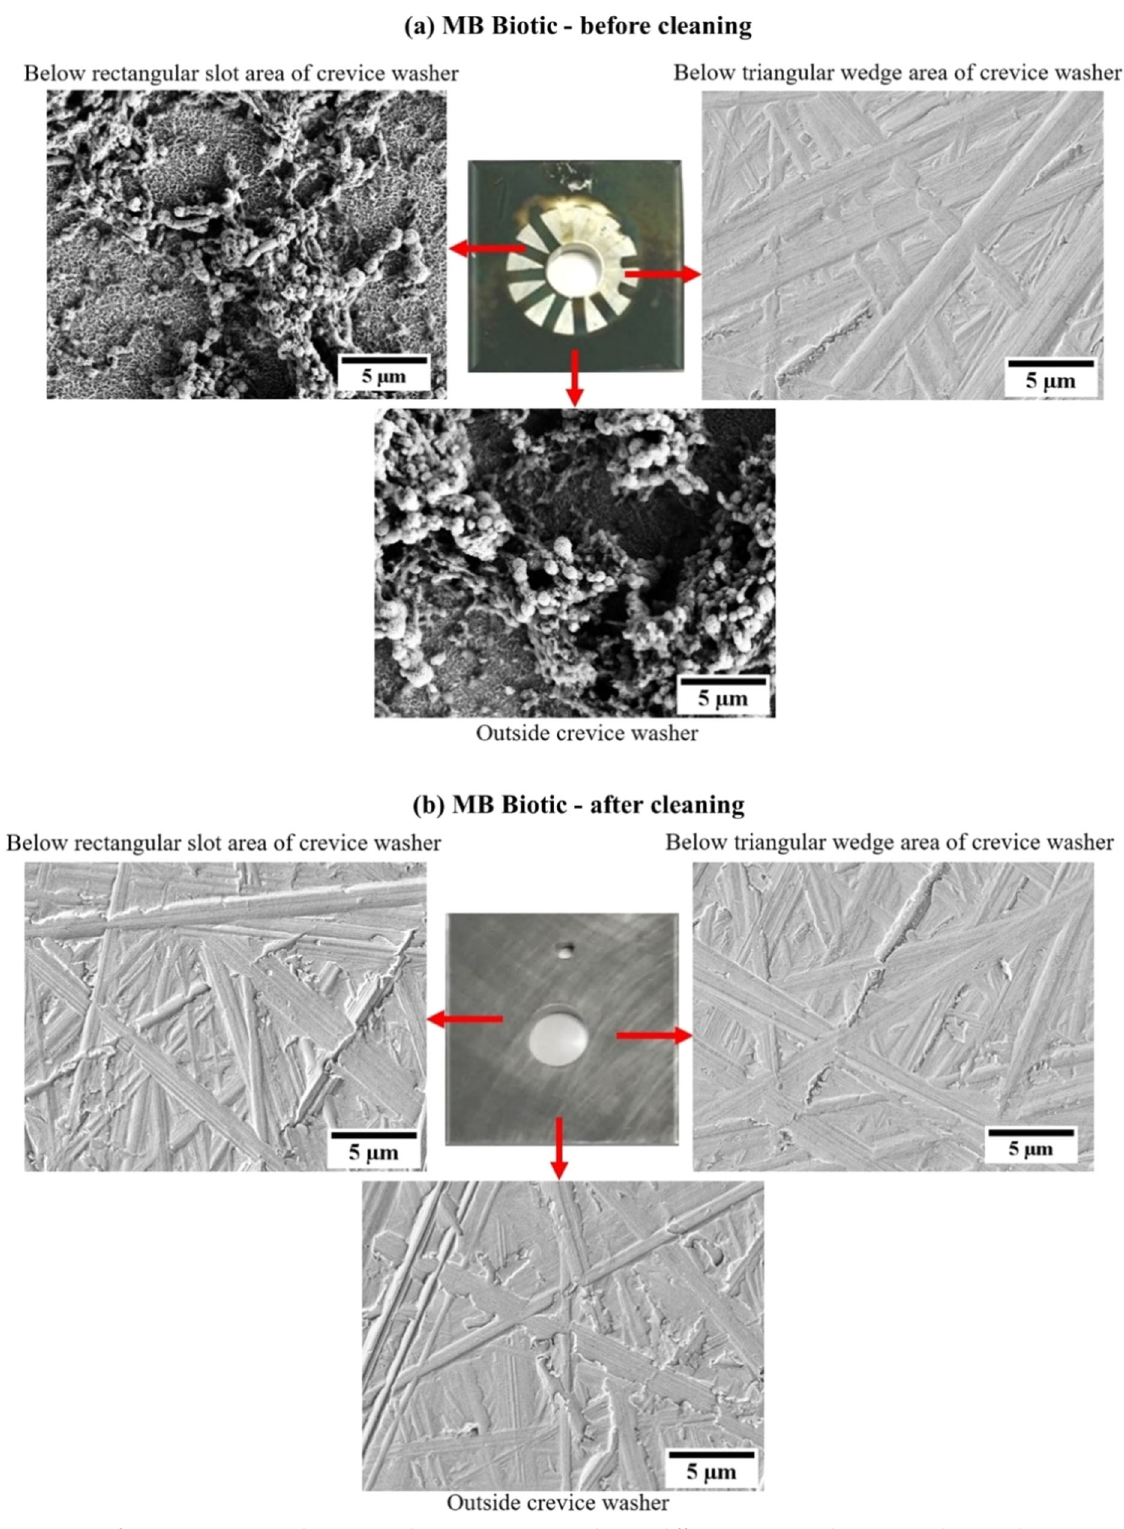
Fig. 3 SEM images of coupons immersed in MB medium. SEM images taken at different areas on the 304 stainless steel coupons at the end crevice corrosion test in MB medium with SRB (a) before cleaning (b) after test conditions, minimal change in the pH was observed between the start and end of the test (constant at ~6.5). On the other hand, The pH of the test media (MB and MBN) was measured at the start for biotic test conditions, the pH of both the media increased to and end of the simple immersion tests for 32 days. For the abiotic more alkaline values, i.e. ~7.9, by the end of the test.